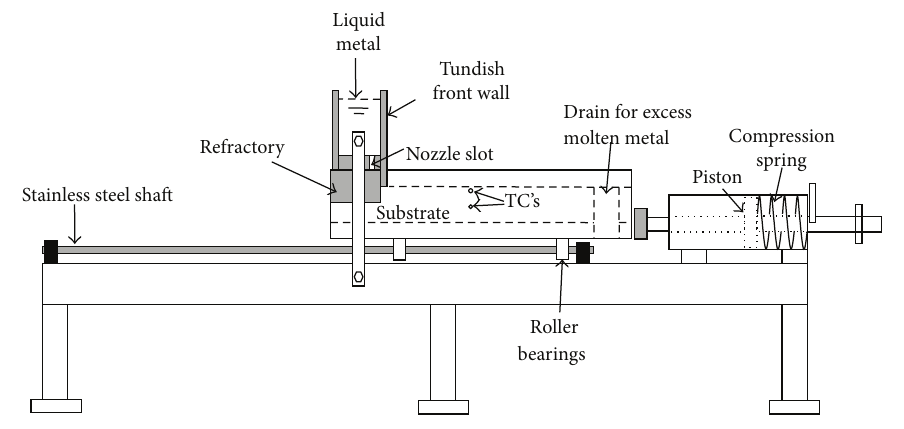
Figure 1: Schematic of the strip casting single belt simulator.